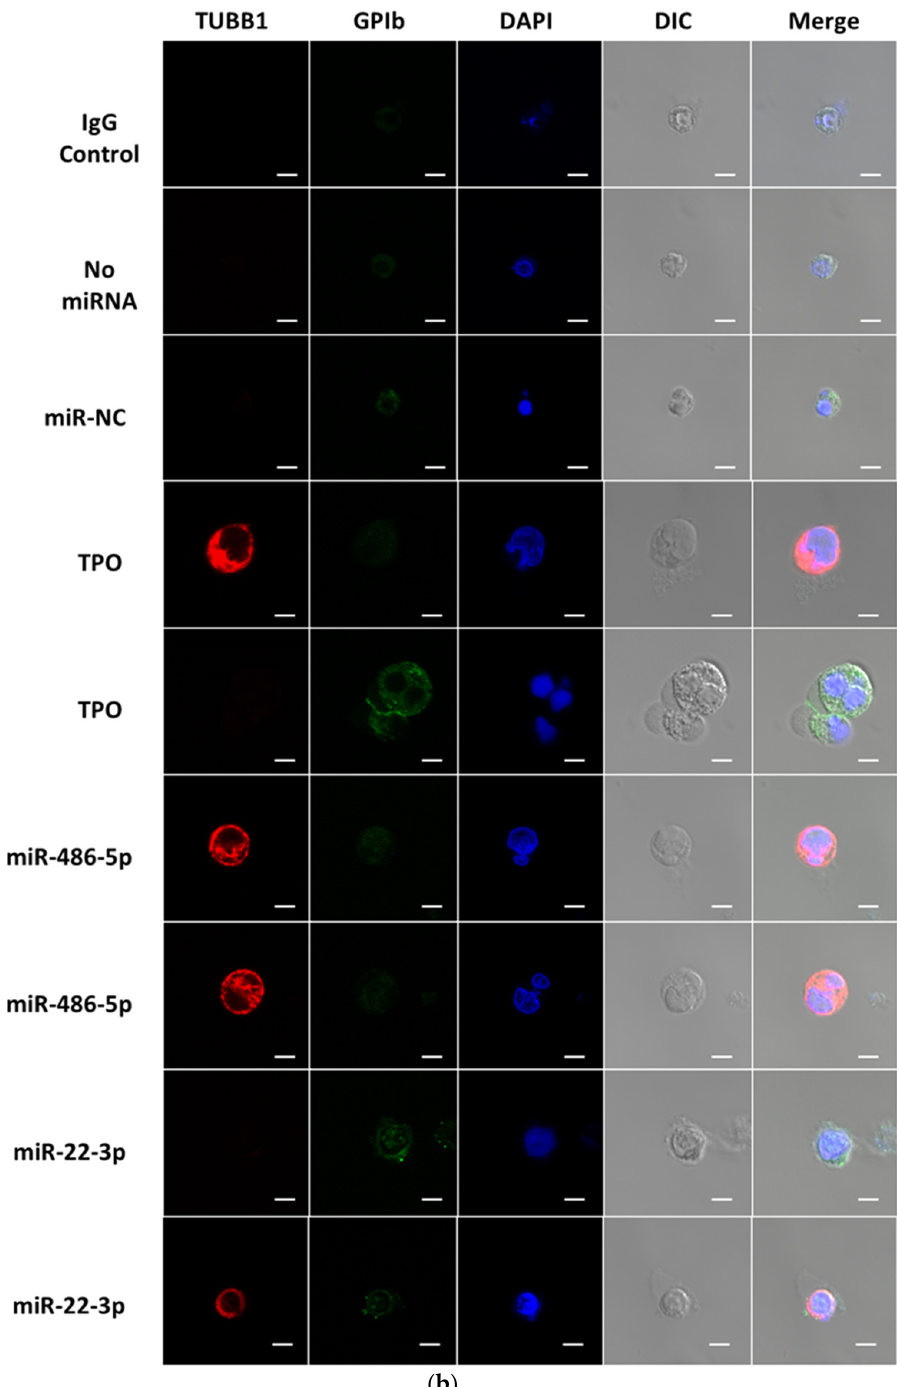
Figure 3. miR-486-5p and miR-22-3p enable Mk differentiation and maturation. CD34 + cells were transfected with miRNA mimics, non-targeting miRNA (miR-NC), or without miRNAs (No miR), and were cultured in minimal medium (IMDM supplemented with 10% BIT and 50 ng/mL SCF) without TPO. Cells cultured in TPO-supplemented medium (100 ng/mL TPO) served as positive control (TPO). ( a ) Cells were harvested at day 13 and stained for 5-HT (cyan), vWF (red), TUBB1 (green), and DAPI (blue). ( b ) In another experiment, cells were harvested at day 13 and stained for TUBB1 (red), GPIb (green), and DAPI (blue). Images were acquired by confocal microscopy. Scale bar: 10 µm. White arrows in ( a ) represent the pre-demarcation membrane system (DMS) structure. Red arrows represent the proplatelet-like structure. Color cyan (5-HT) and red (vWF) intensity has been uniformly enhanced in order to show the cellular details.